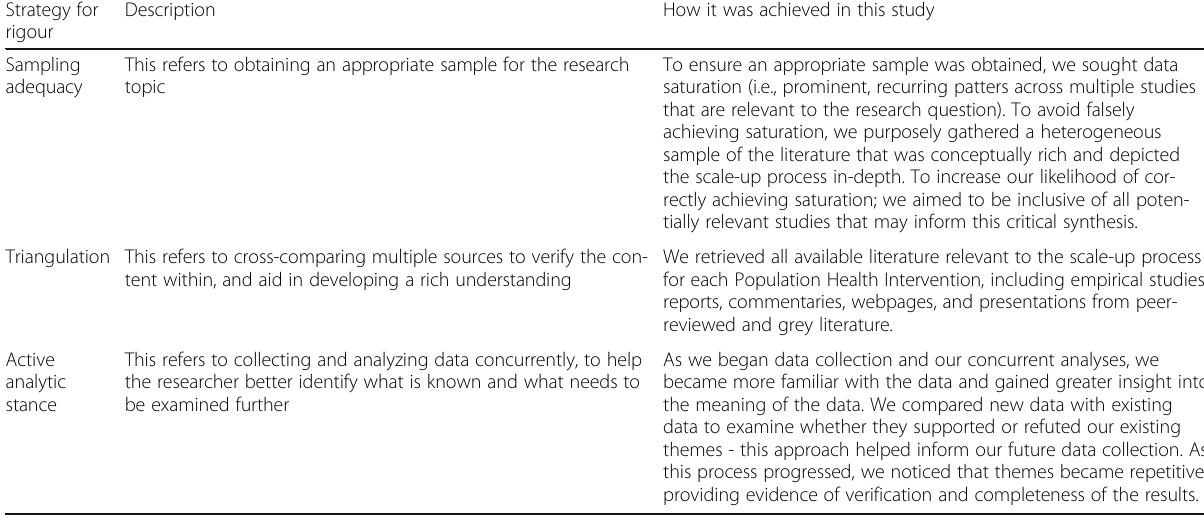
Table 2 Rigour techniques for qualitative